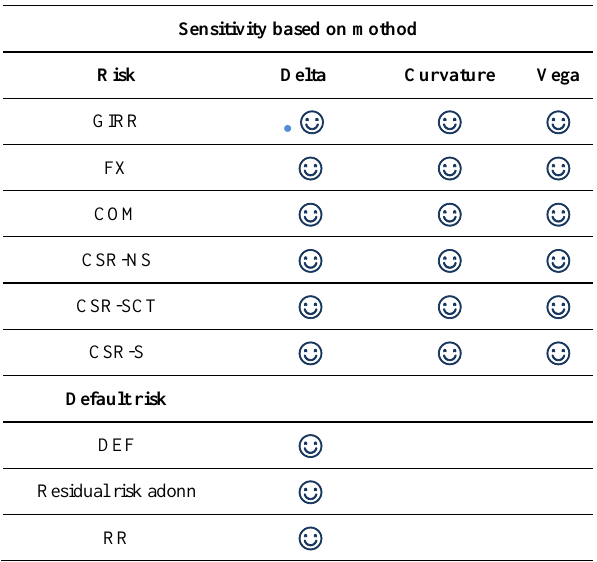
Table 6. What measure for what kind of